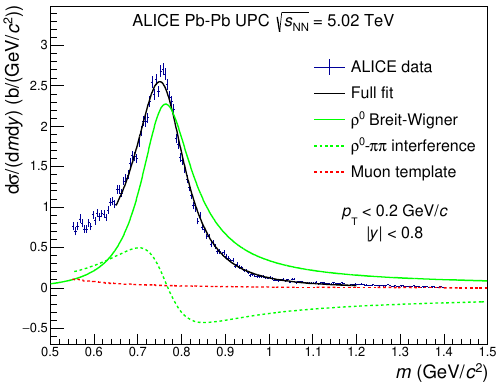
Figure 3 . (Colour online). Invariant mass distribution of pion pairs with the di(cid:11)erent components of the (cid:12)t represented by lines. See text for